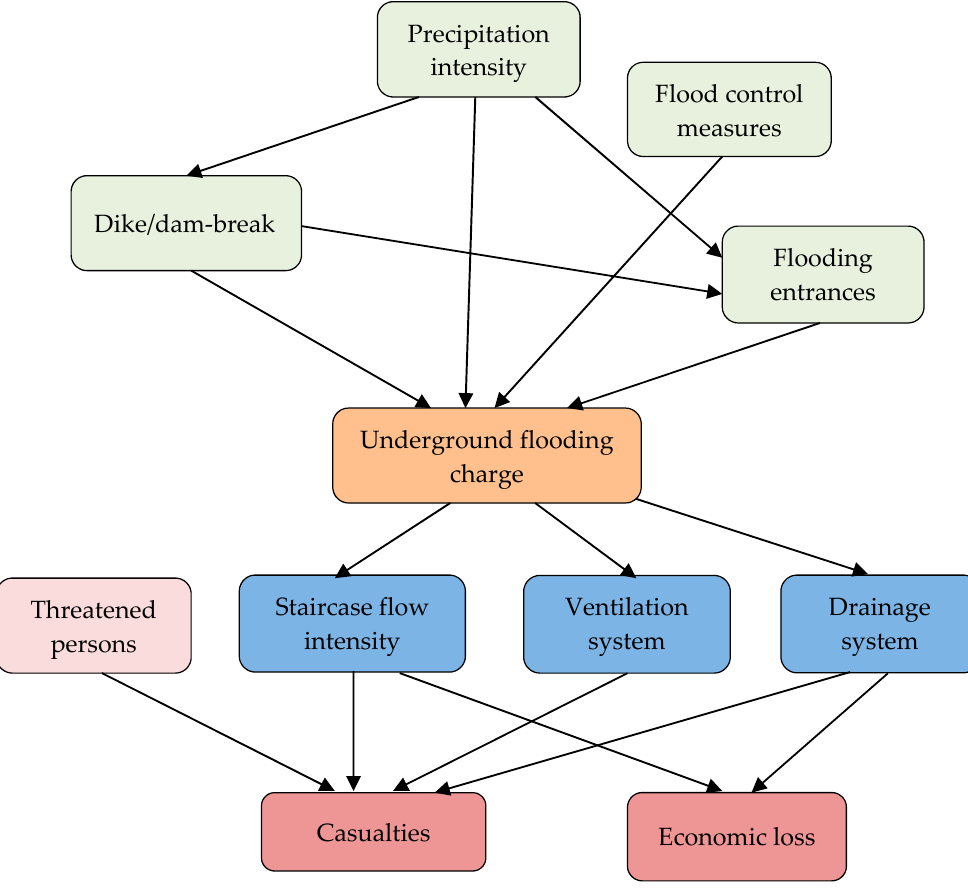
Figure 3. Bayesian network of flooding in underground space.